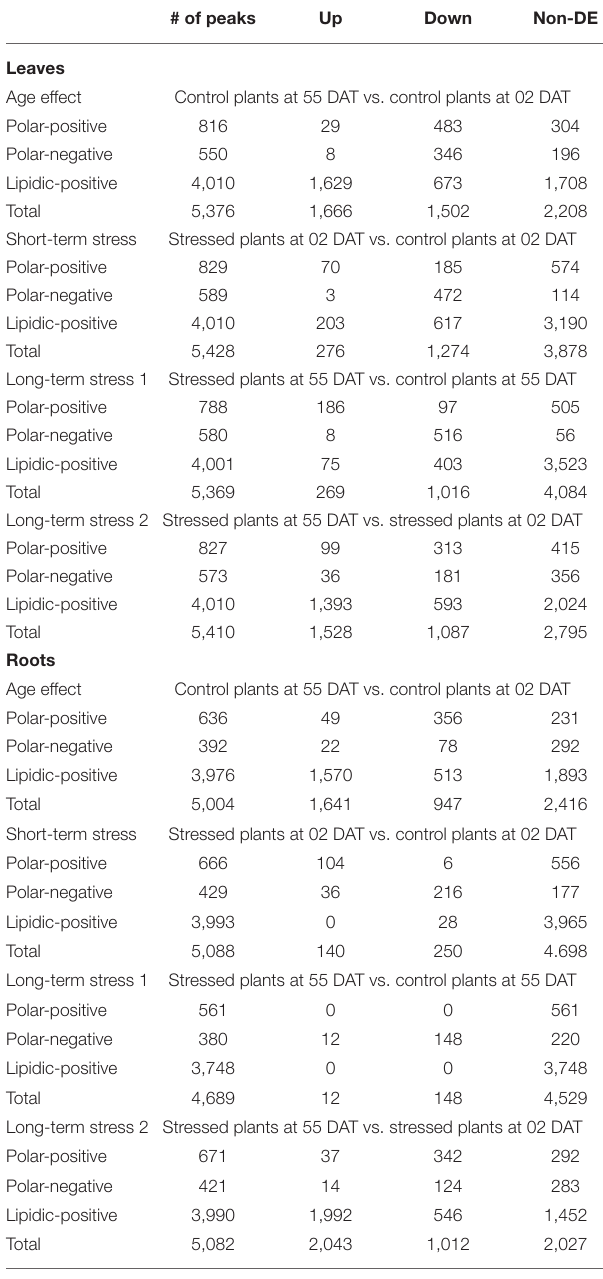
TABLE 1 | Differentially expressed peaks and features in the leaves and roots of gliricidia plants submitted to salinity stress in four distinct scenarios: age effect—AE (control plants at 2 and 55 days under salinity stress—DAT); short-term stress—STS (control and the stress plants at 2 DAT); long-term stress